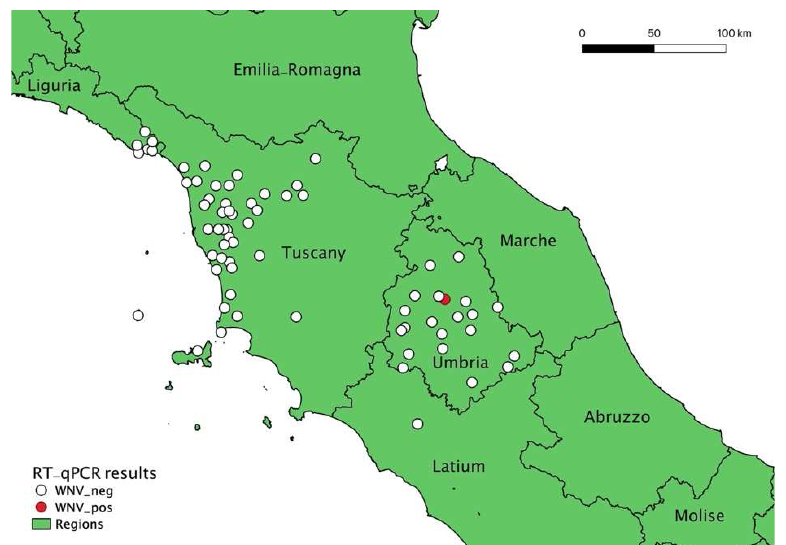
Figure 1. Geographical distribution of sampling sites and positive case location (QGIS map). The map shows the sites of wild birds sampling (white dots) distributed in Umbria, Lazio, Tuscany, and the location of the WNV-positive little grebe ( Tachybaptus ruficollis subsp. ruficollis ) (red dot).